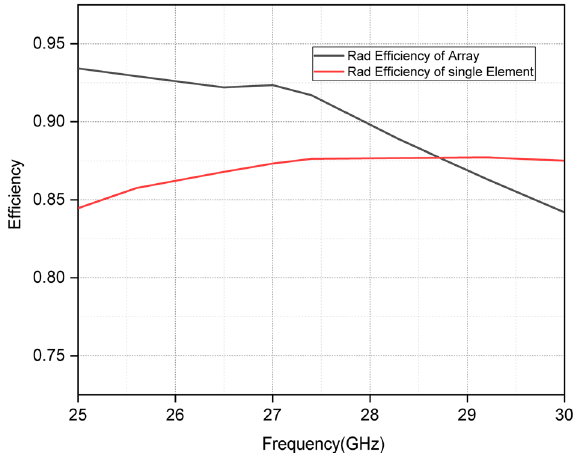
Figure 8. Radiation efficiency of single antenna and antenna array.